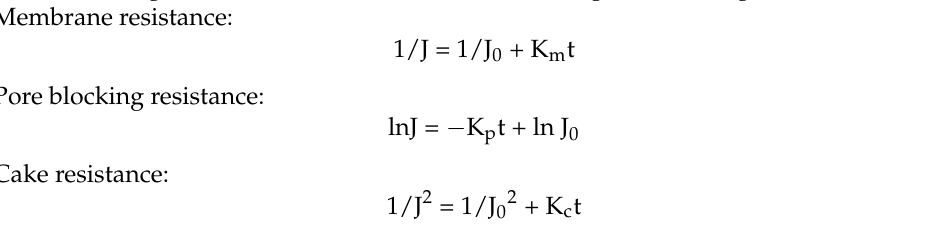
Figure S1: Schematic diagram of the membrane system for 2,3-BDO production in a membrane bioreactor; The detailed information of the modified DSMZ 879